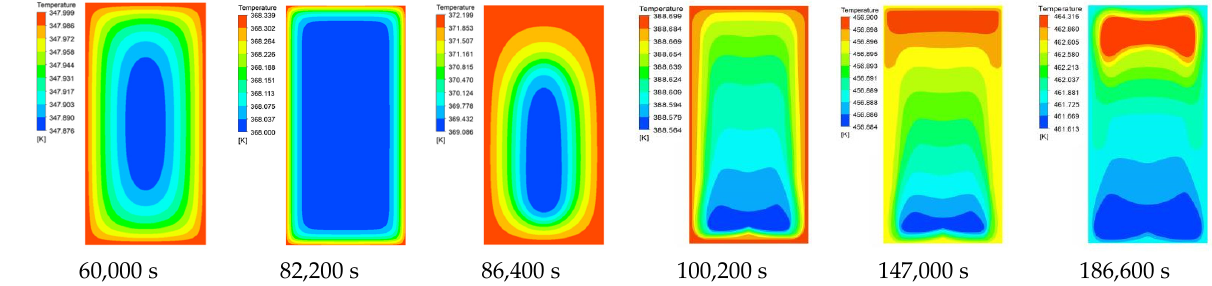
Figure 8. Temperature cloud diagram of 50% spherical NQ/50% DNAN at different times.